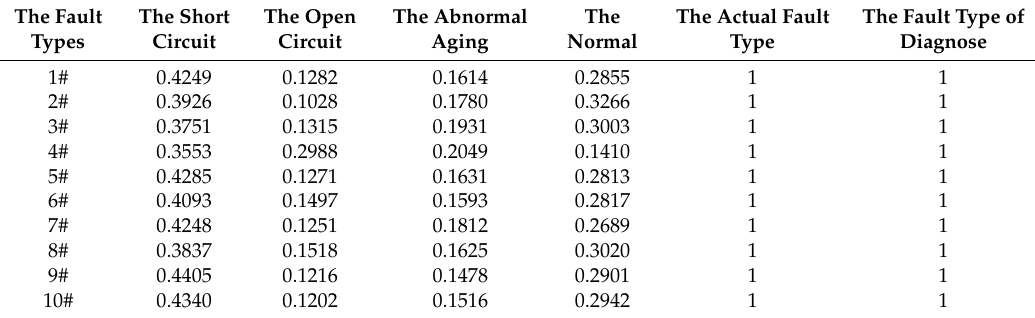
Table 4. The final posteriori probabilities of 10 test sample groups in short-circuits state.